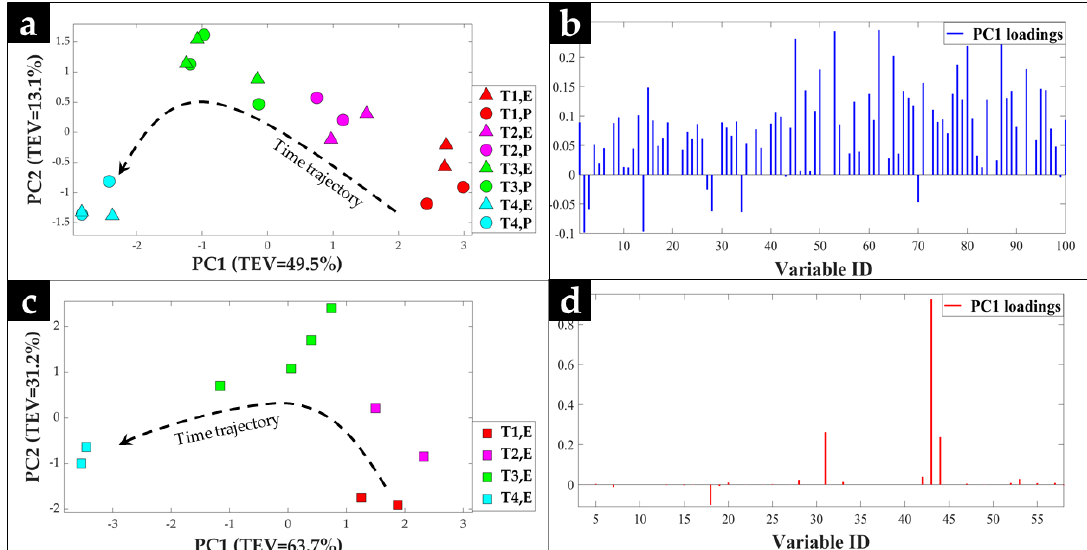
Figure 2. PCA scores and loadings plots of the GC-MS data acquired from samples analyzed in ( a , b ) the Manchester, and ( c , d ) the Leuven laboratories, respectively. Di ff erent colors indicate the various timepoints, while the symbols represent the sample sets, Manchester extracts (triangle, E), Manchester cell pellet (circle, P), and Leuven extract (square, E). The arrows illustrate the main trajectories with respect to time. The values in parentheses are total explained variance